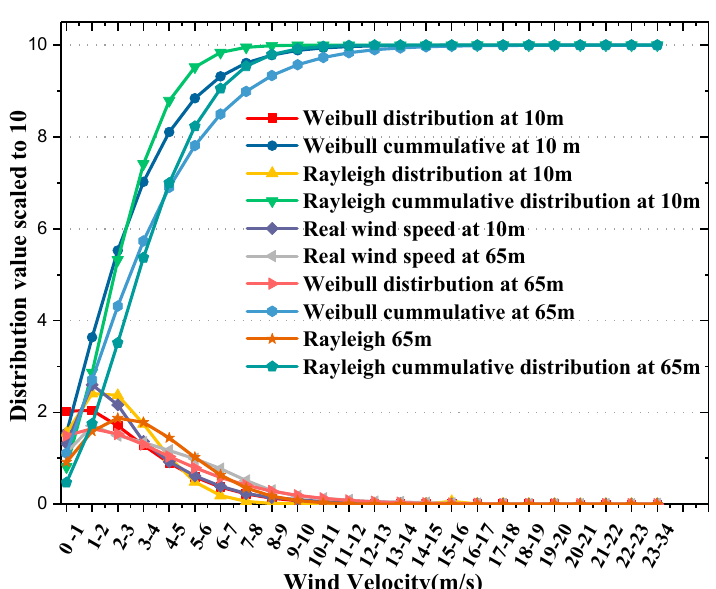
Figure 6. Annual ( a ) Rayleigh and ( b ) cumulative distribution from 2012 to 2017 at 65 m hub height.